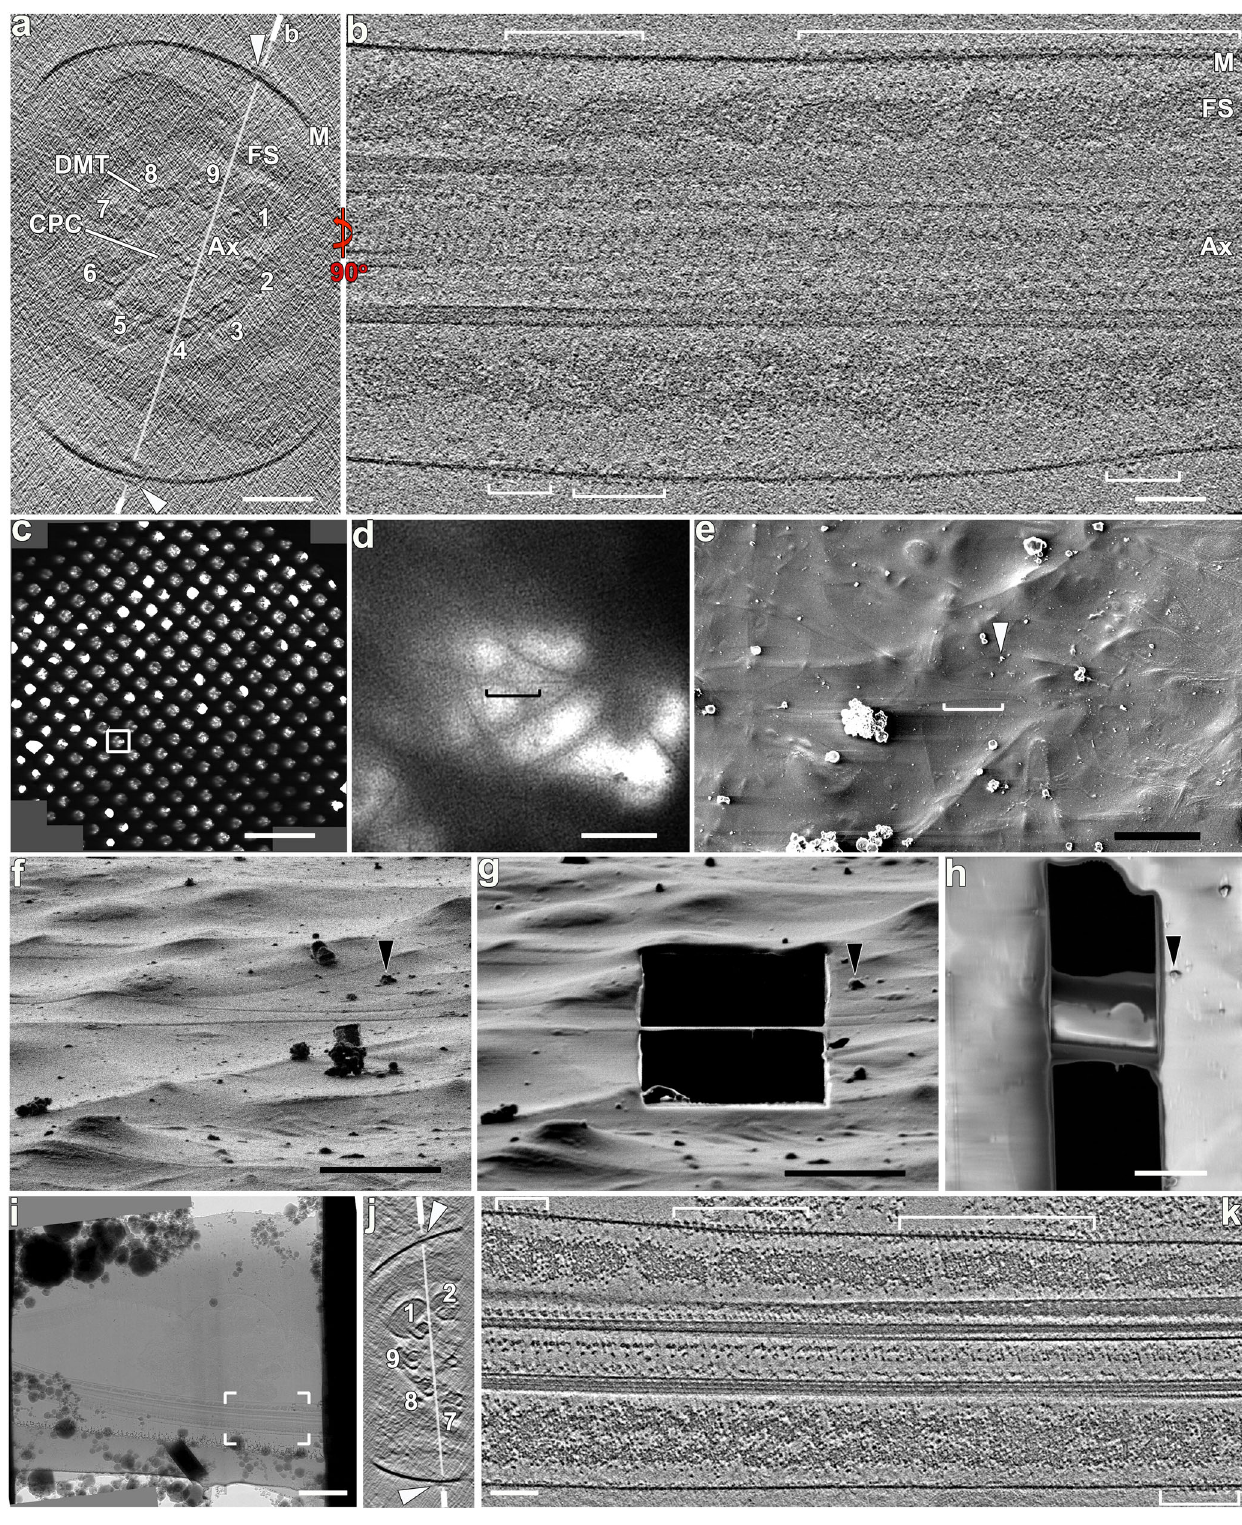
microtubule doublet number 1 21,22 . Given that the CatSper channels form four nanodomains in mouse and human sperm laterally on each side of the two longitudinal columns of the fi brous sheath 8,14,16 (Figs. 1 and 2), it remains to be determined whether the fl agellar zippers in these rodent species are related to the CatSper